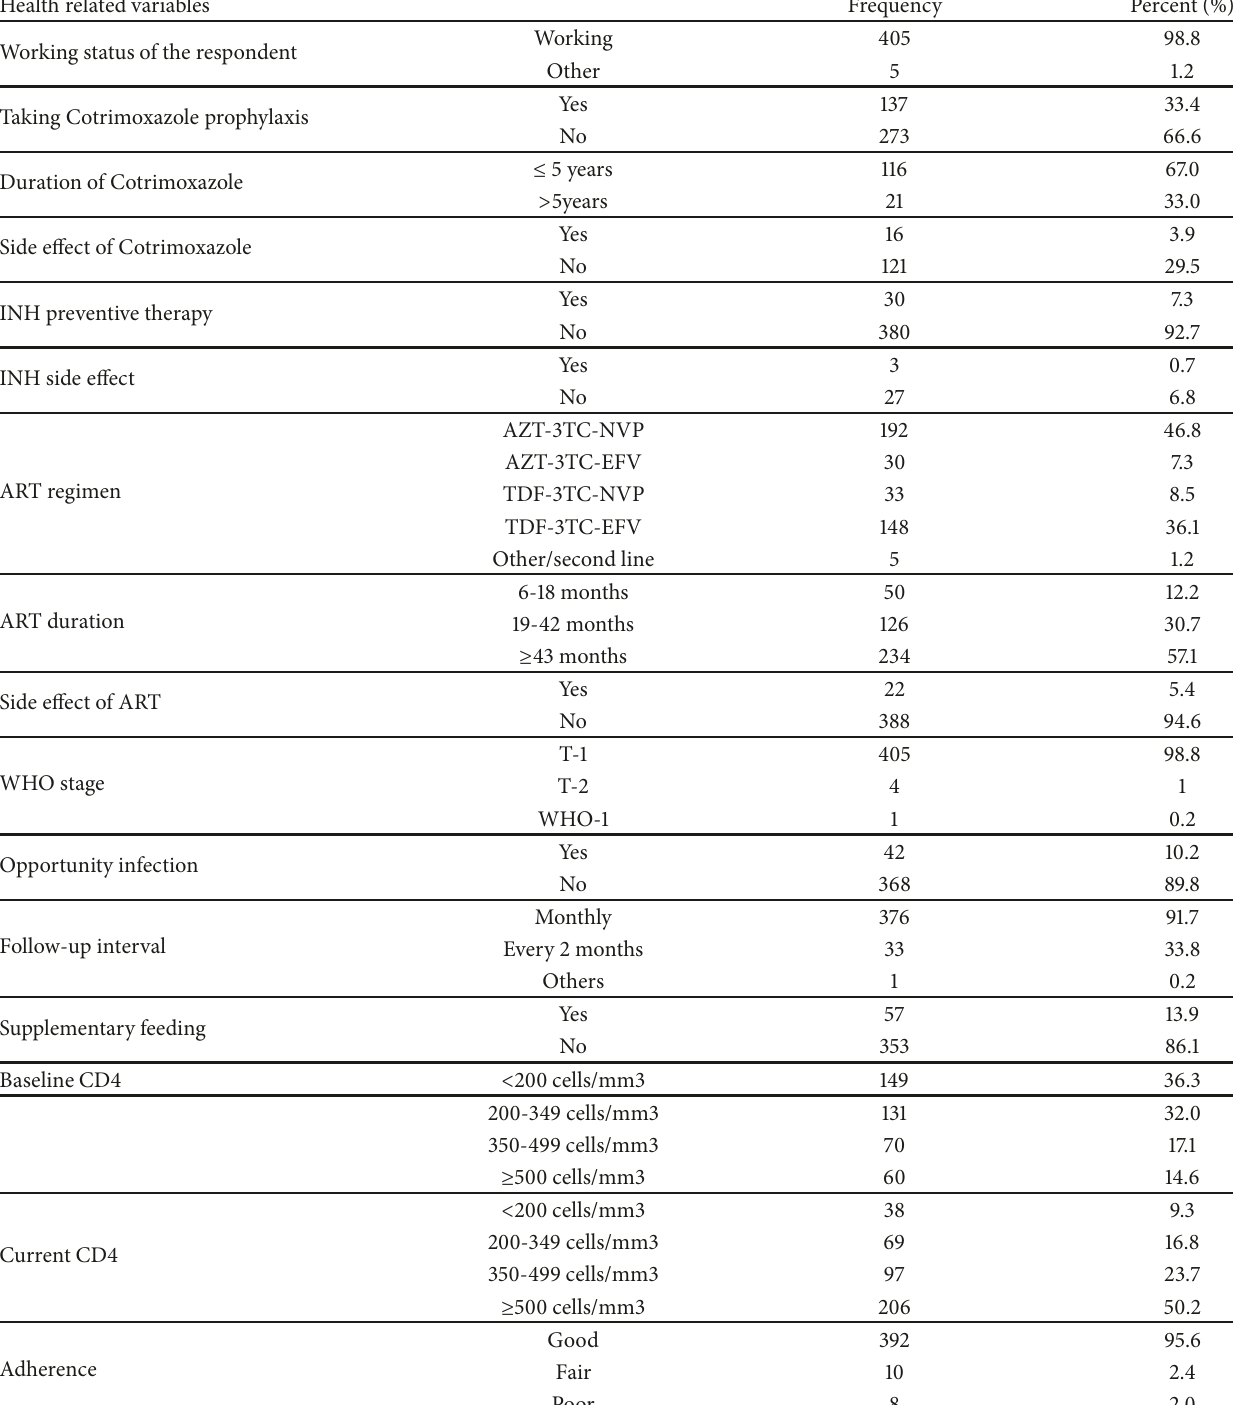
Table 2: Health related information of adult HIV patients in Motta administrative town, April,